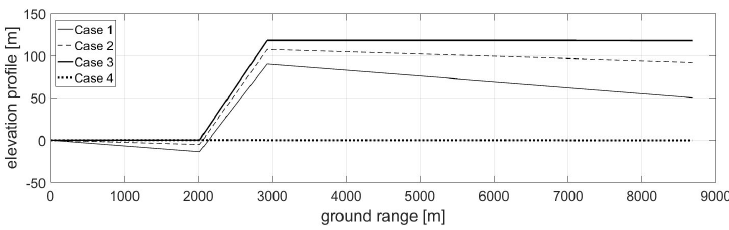
Figure 5. Comparison of estimated range profiles for damp soil region assuming different a priori knowledge. Case 1 (continuous line): no a priori knowledge is assumed and both calibration and